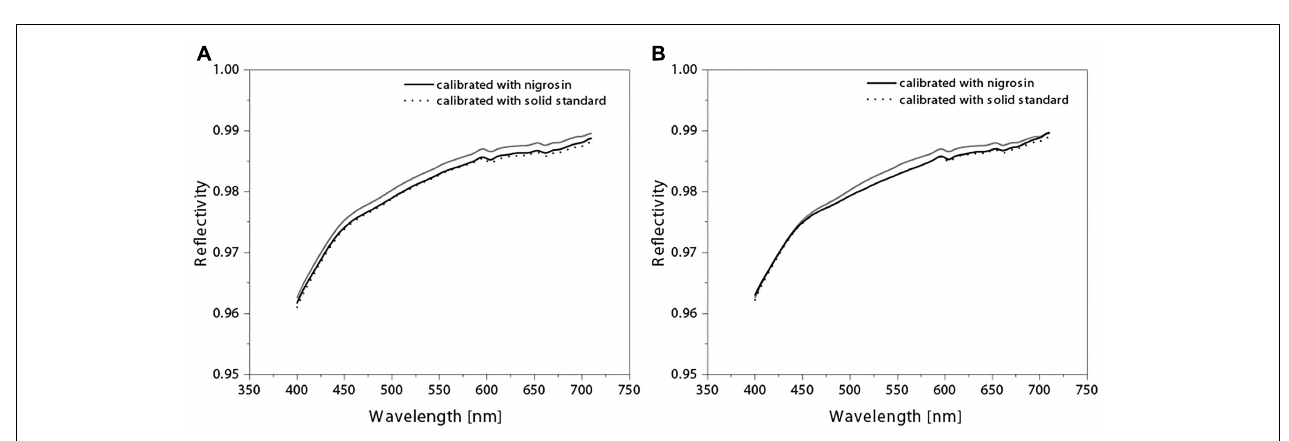
FIGURE 7 | Comparison of nigrosin-based and solid standard-based calibration. (A) Reflectivity was altered by application of a black tape on the cavity wall. (B) Reflectivity was altered by rinsing the cavity with a concentrated nigrosine solution. The gray curve represents the reflectivity of the initial calibration for